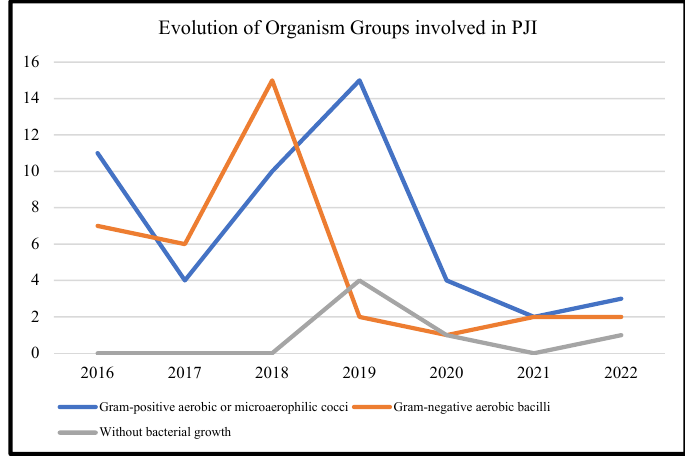
Figure 2. Trends in the microbial etiology of PJIs.